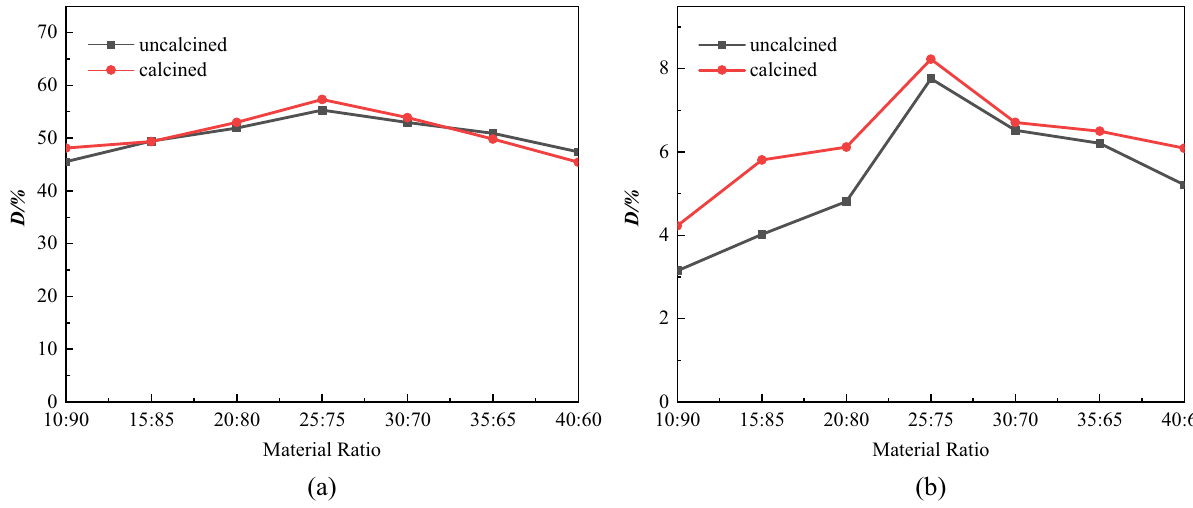
Figure 8: Photocatalytic degradation e ffi ciency of calcined and uncalcined CdS/TiO 2 composite photocatalysts. ( a ) UV irradiation, ( b ) Sunlight